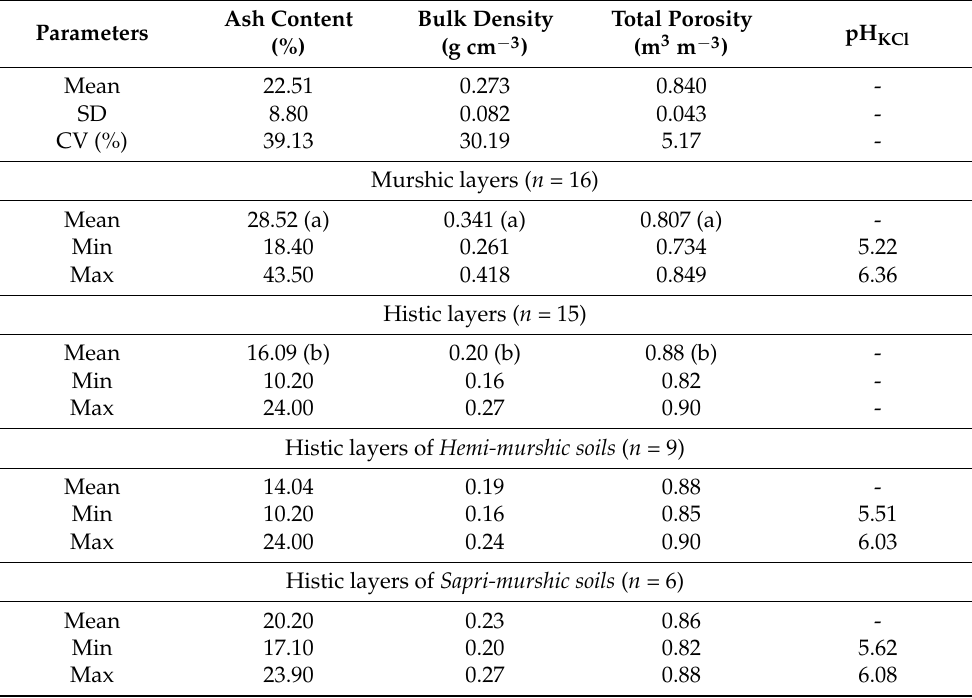
Table 4. Values of descriptive statistics of physical properties and pH.